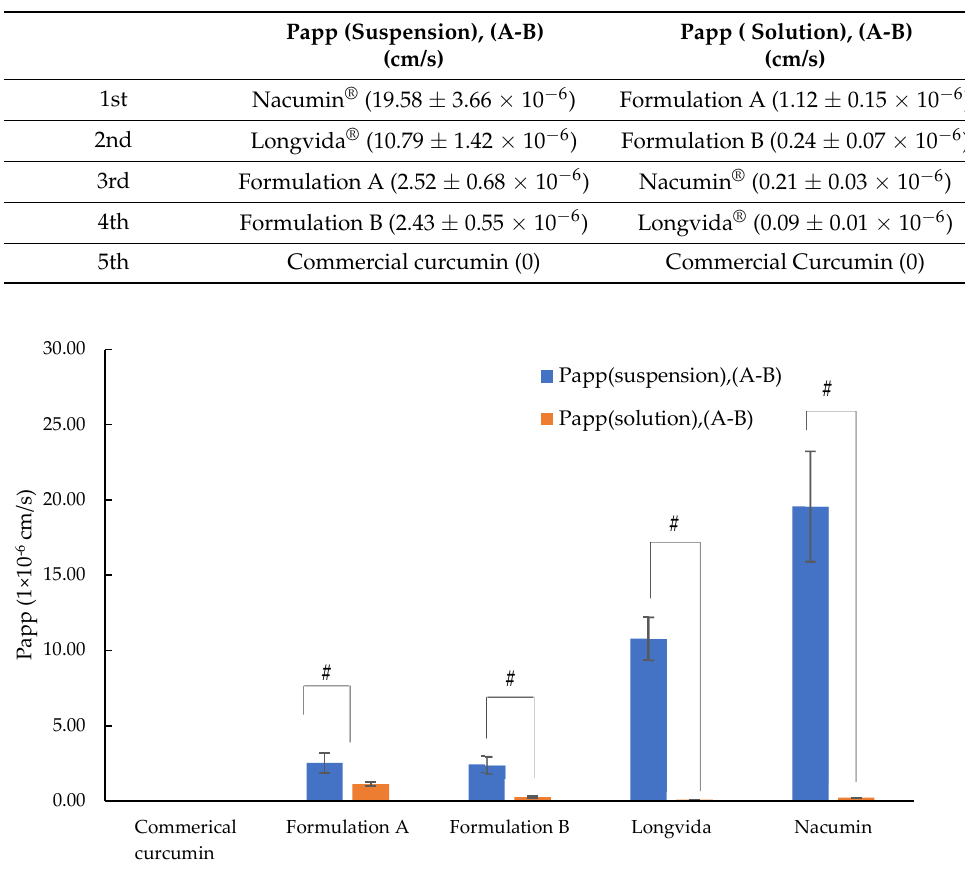
Figure 14. Comparison of Papp (suspension), (A-B) and Papp (solution), (A-B) ( n = 9, mean ± SD). # Denotes statistically significant differences between Papp (suspension), (A-B) and Papp (solution), (A-B) of each formulation ( p ≤ 0.05).